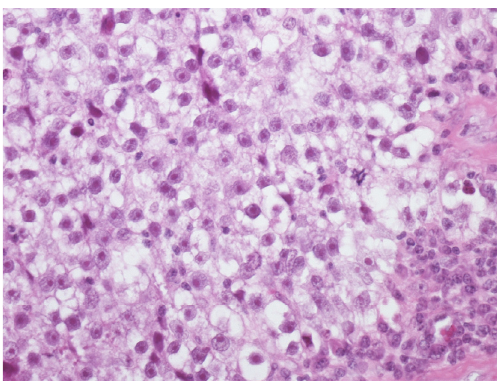
Figure2:Histologicalsectionoftheorchiectomyspecimenshowing pure seminoma. Haematoxylin-eosin stain, original × 100.